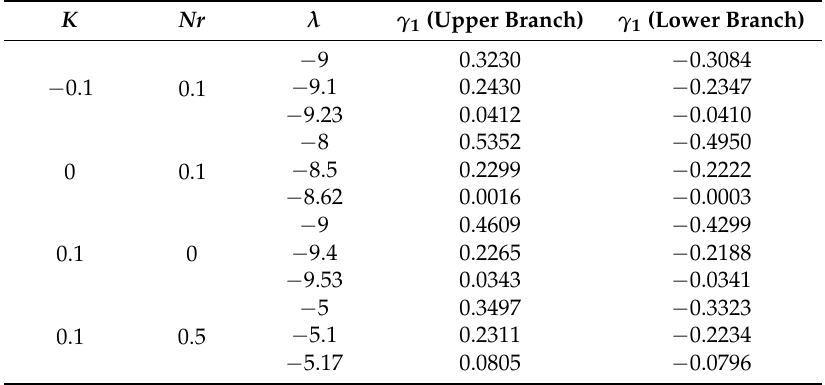
Table 3. Smallest eigenvalues γ 1 for various values of K , Nr and λ